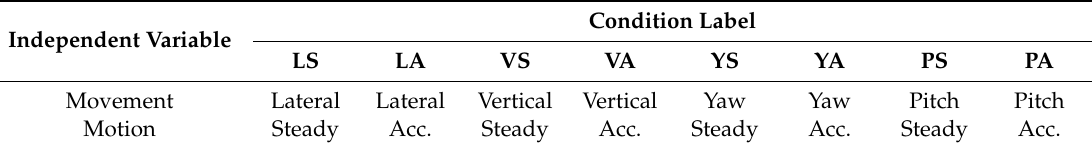
Table 2. Experimental conditions with labels.